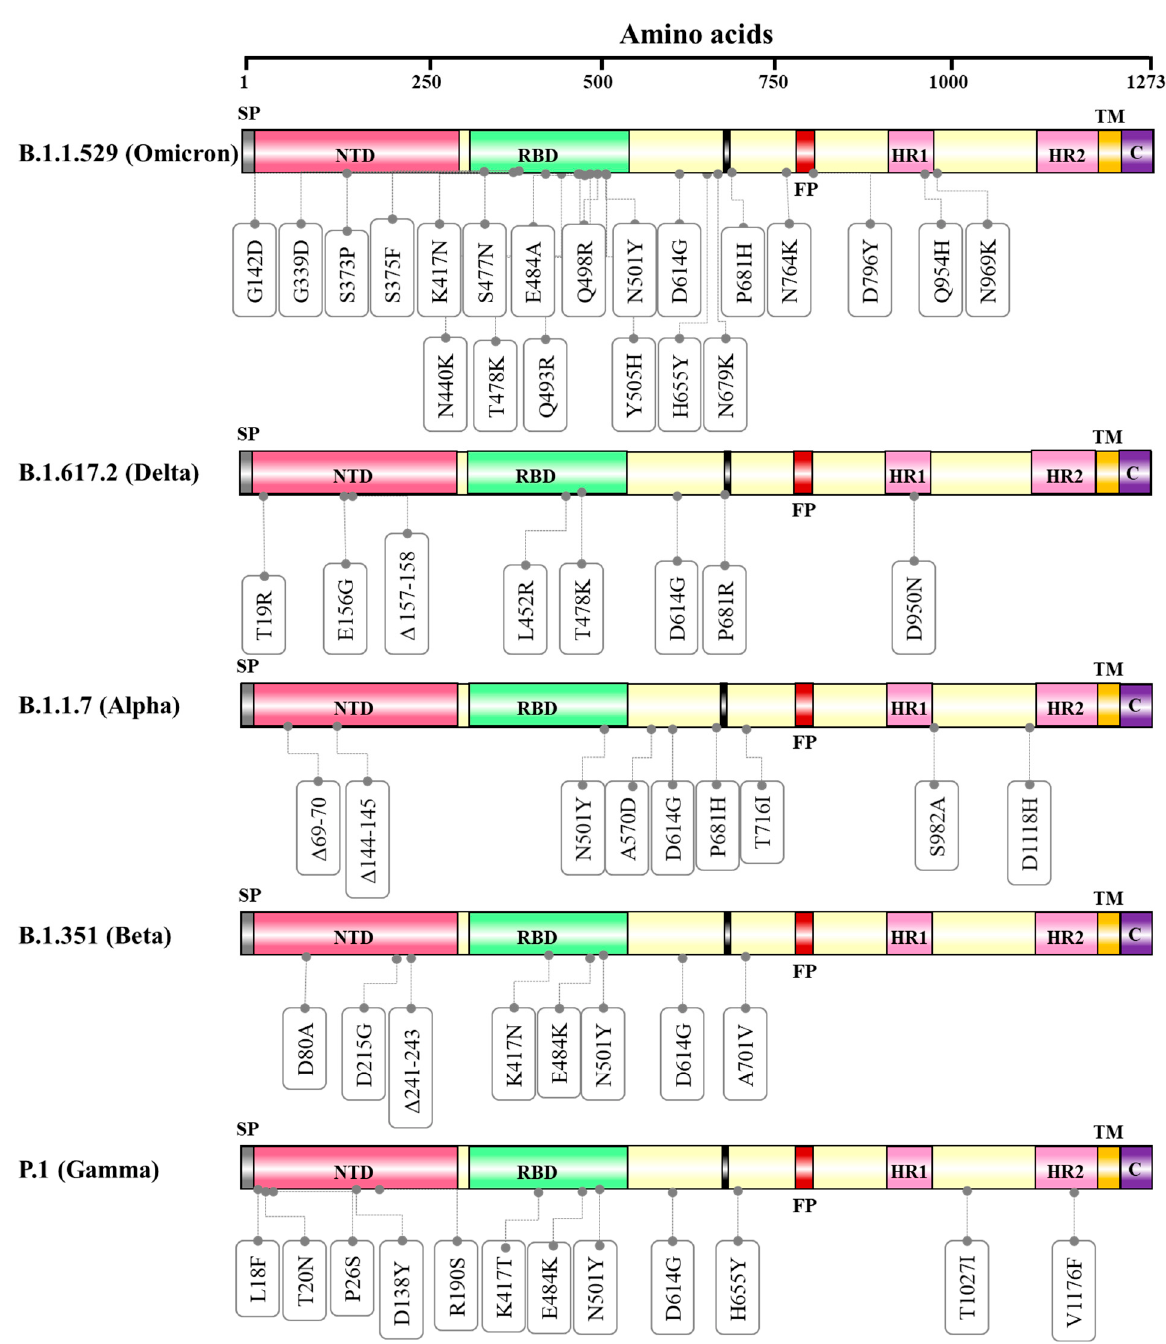
Figure 3. Mutations reported in amino acid positions of spike glycoproteins (S) in current circulating variant of concern (VOC): Omicron (5.1.1.529) and some Variants Being Monitored: Delta (B.1.617.2), Alpha (B.1.1.7), Beta (B.1.351), and Gamma (P.1).